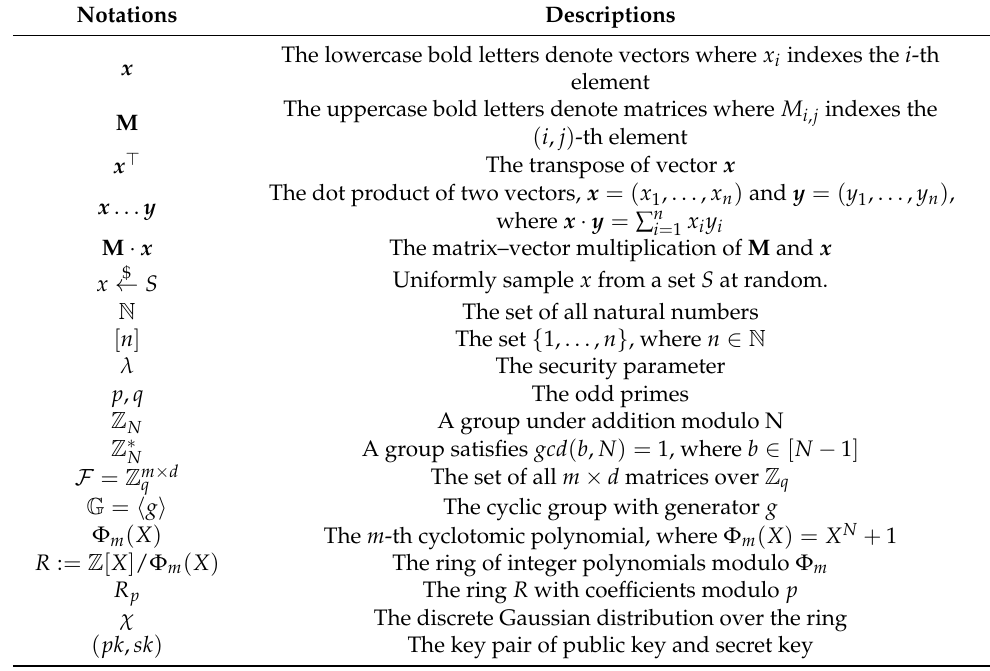
Table 2. Summary of